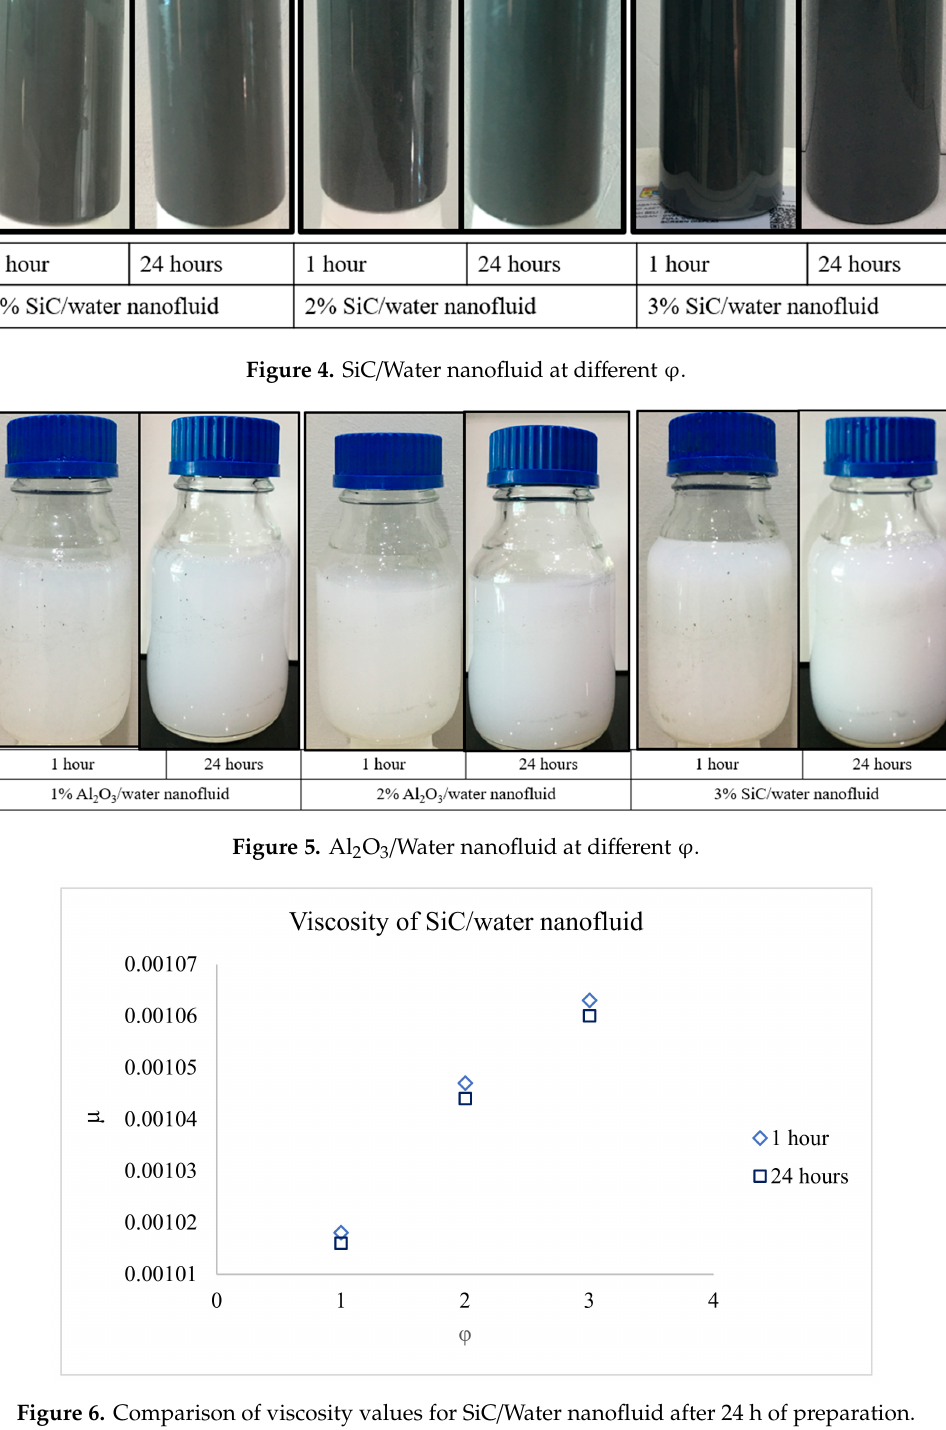
Figure 6. Comparison of viscosity values for SiC / Water nanofluid after 24 h of